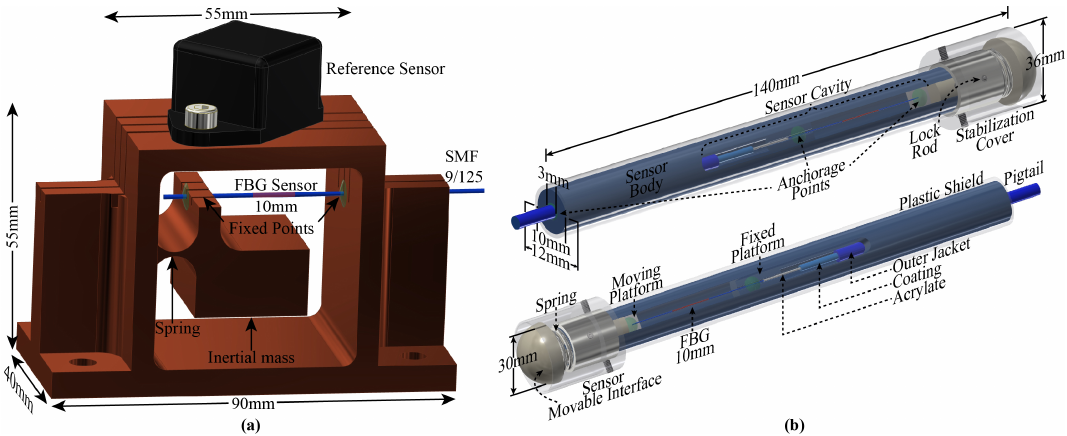
Figure 2. Schematics of the FBG-based sensors: ( a ) Optical accelerometer; ( b ) Central arterial pulse wave probe